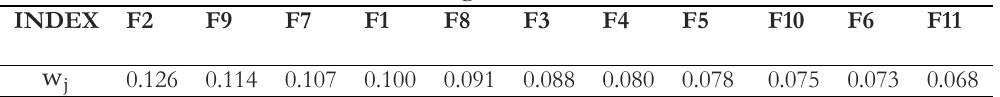
Table 12. Weight of each index.